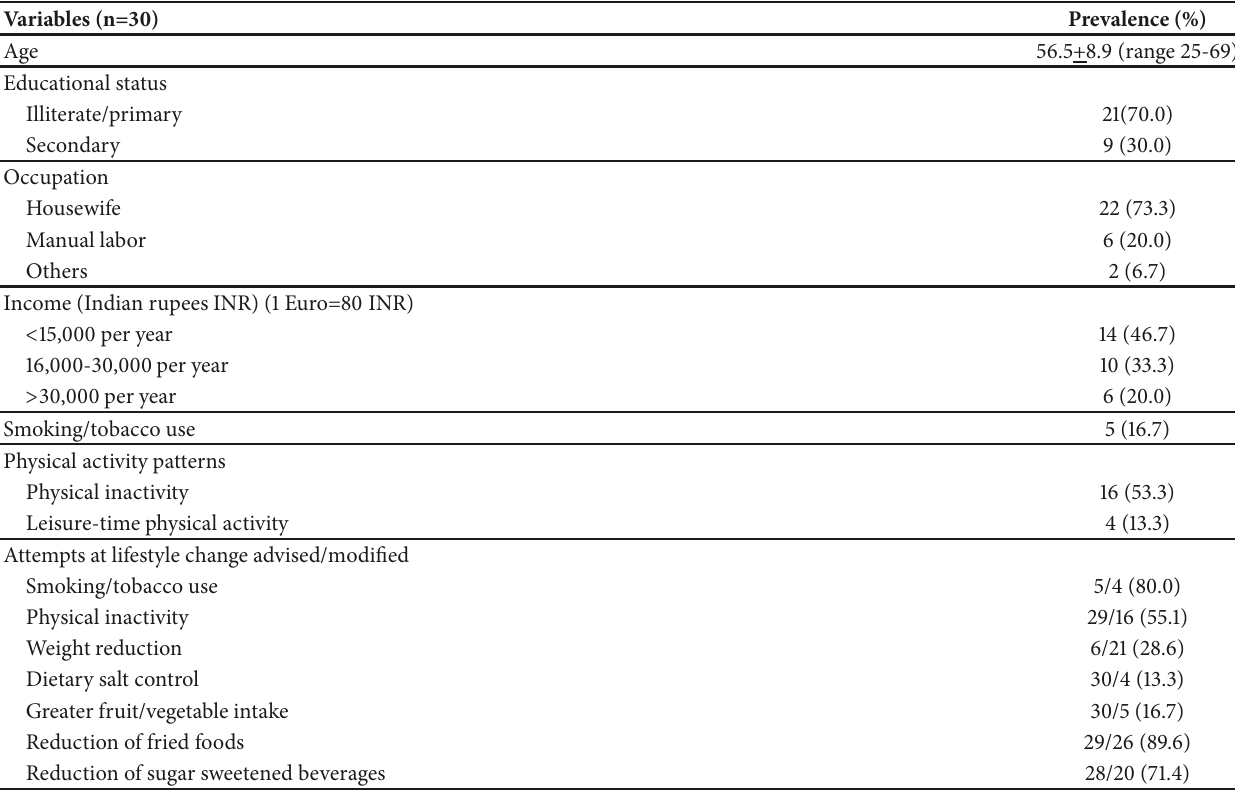
Table 2: Sociodemographic characteristics and risk